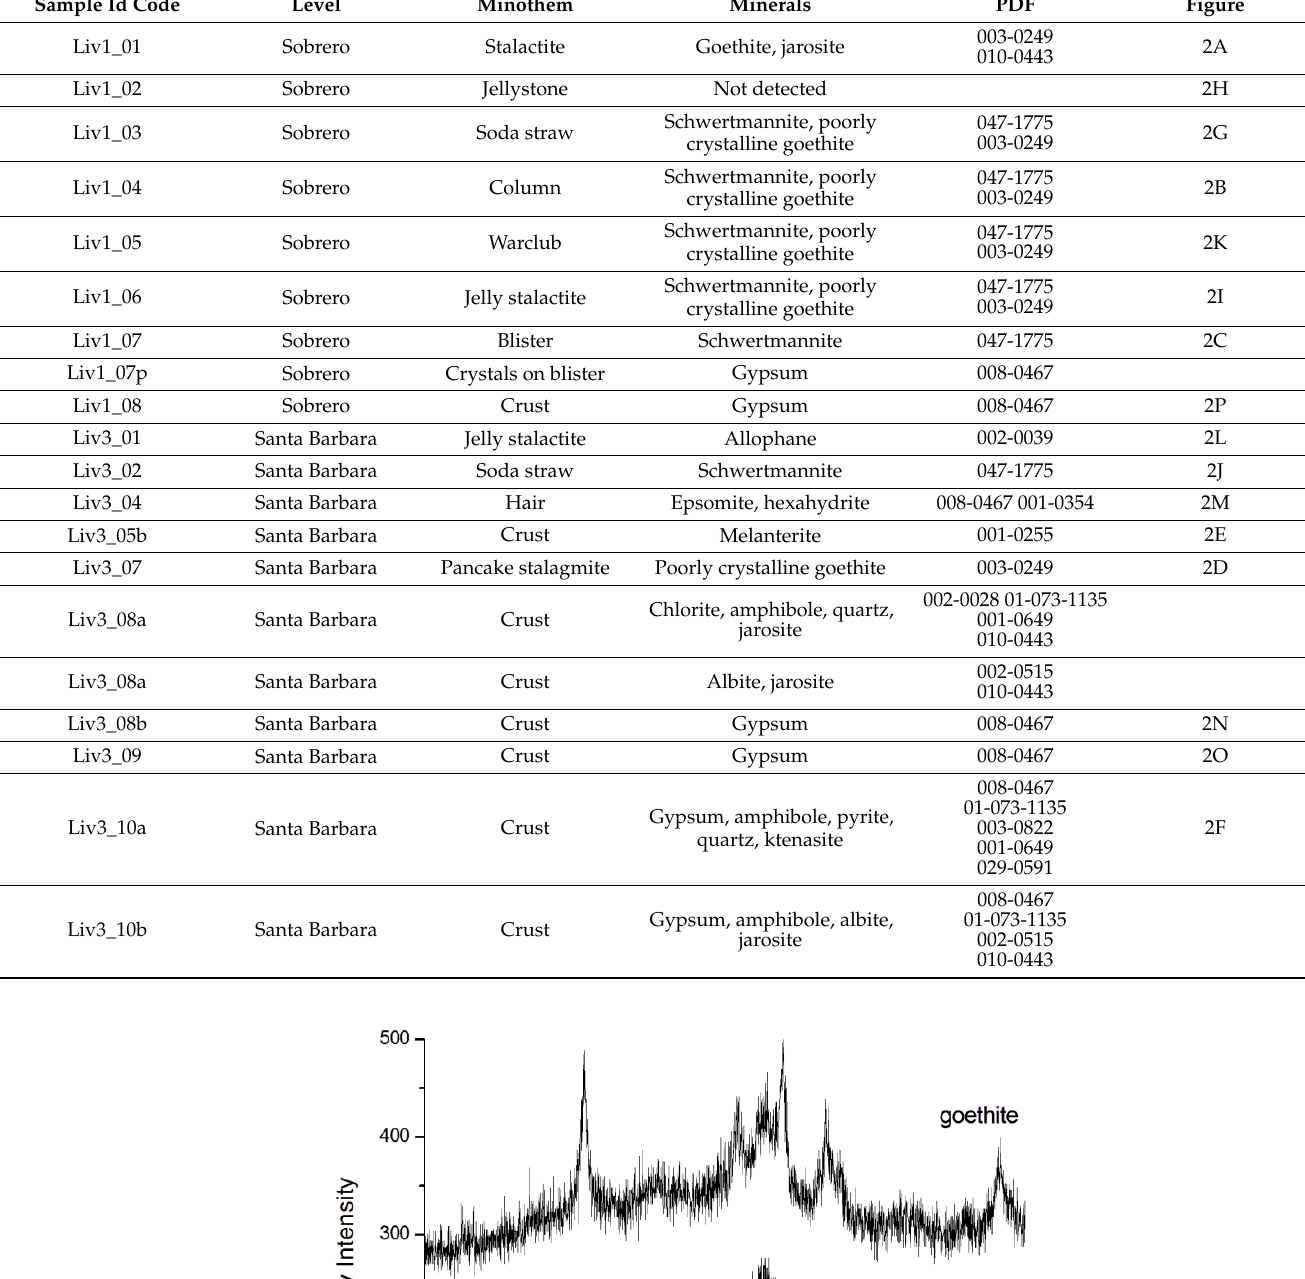
Table 1. Results of XRPD analysis on Fragn è mine samples.